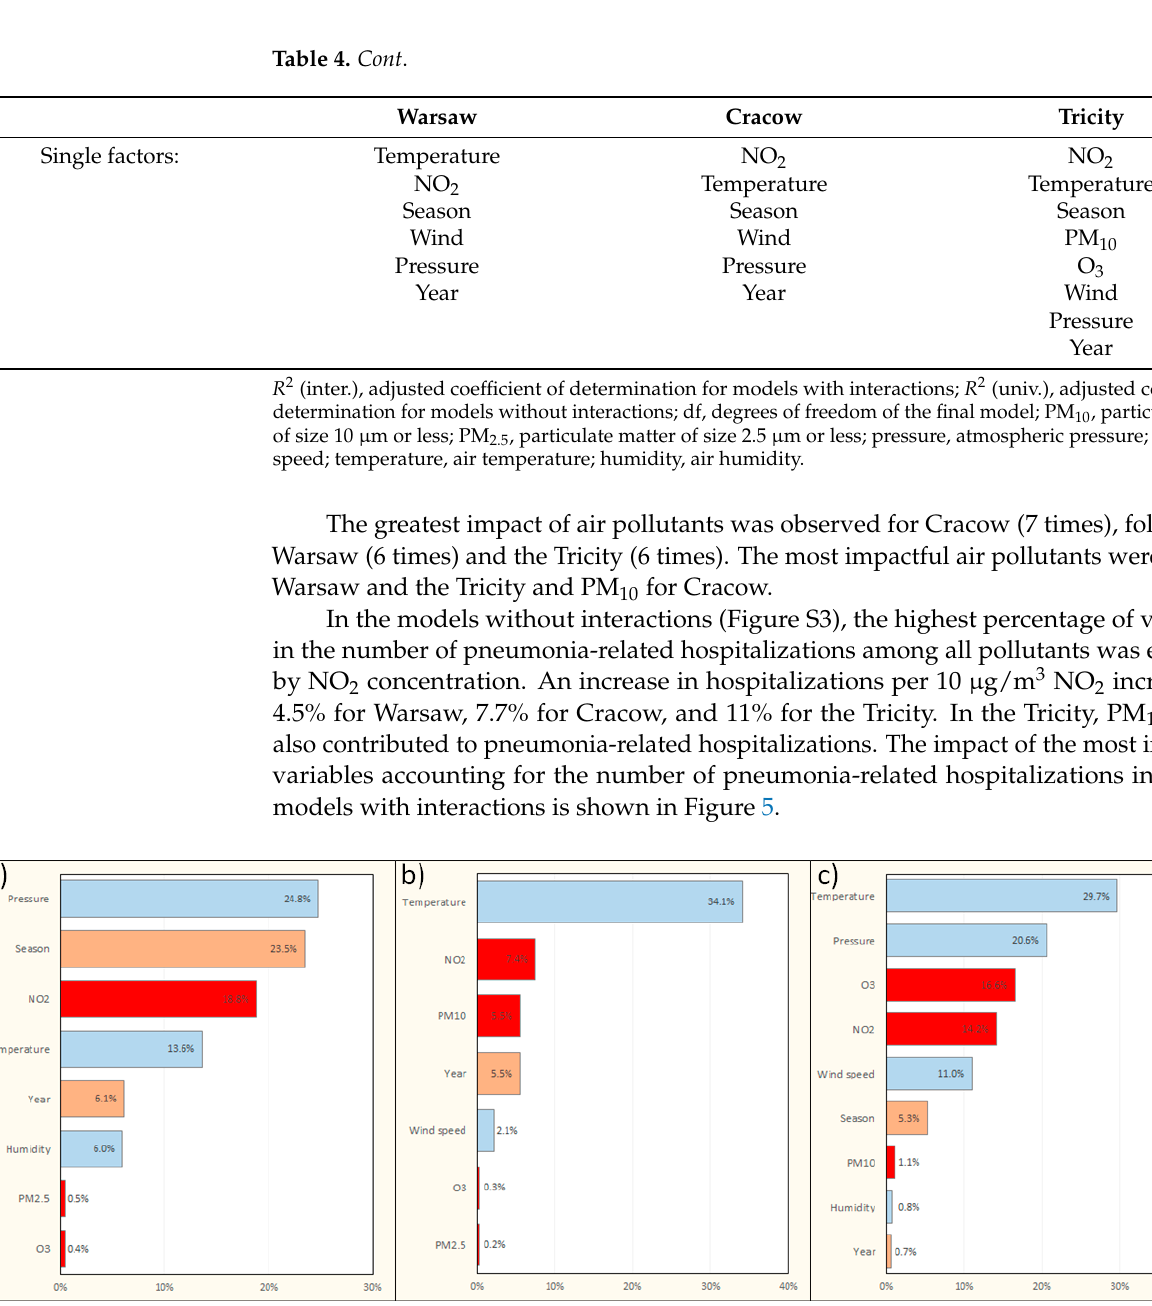
Figure 5. Pareto B graphs showing the impact of the most influential individual variables on the number of pneumonia-related hospitalizations in the final models with interactions. ( a ) Model for Warsaw; ( b ) model for Cracow; ( c ) model for the Tricity. Factors associated with weather conditions are marked in blue, factors associated with air pollution are marked in red, and factors associated with seasonal/annual variability are marked in orange. PM 2.5 , particulate matter of size 2.5 μ m or less; PM 10 , particulate matter of size 10 μ m or less.